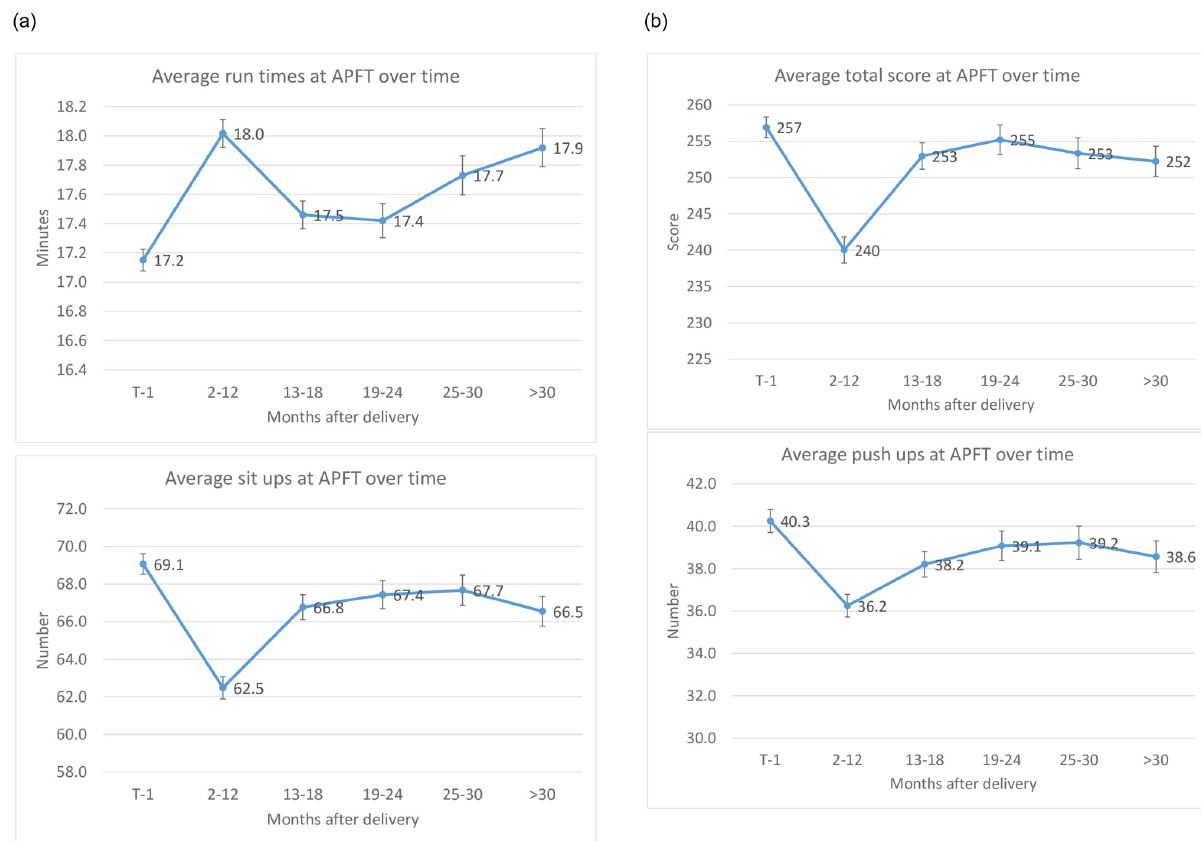
Fig 3. Postpartum APFT event raw scores and overall scores over time. APFT, Army Physical Fitness Test. Pre- denotes the last pre-pregnancy APFT. � P < 0.01 vs pre-pregnancy.